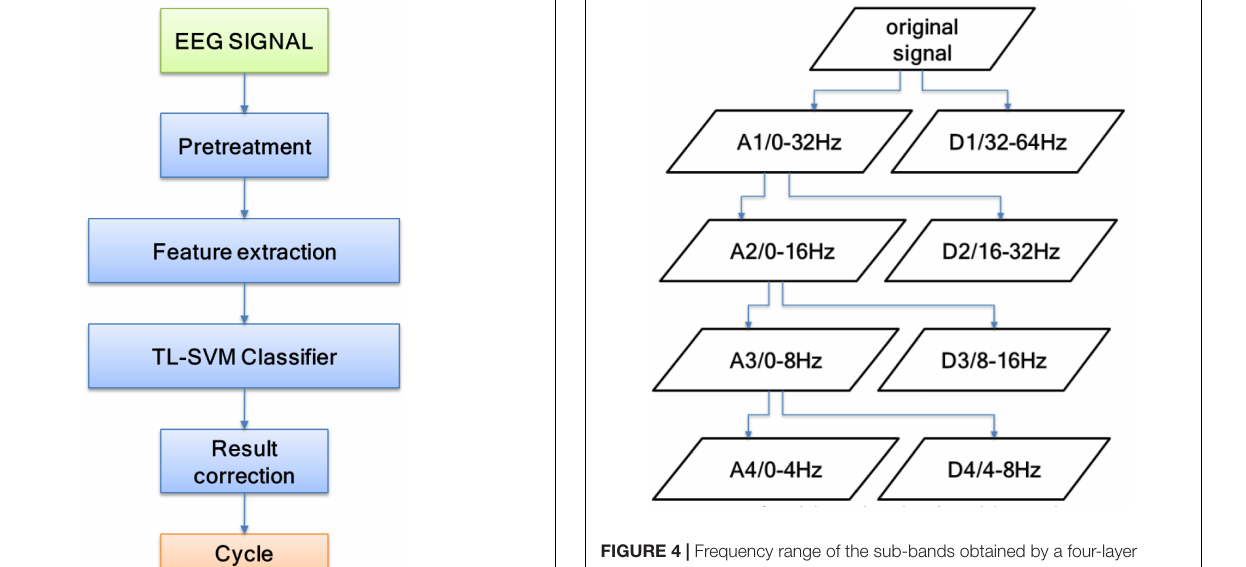
FIGURE 4 | Frequency range of the sub-bands obtained by a four-layer discrete wavelet transform (DWT)